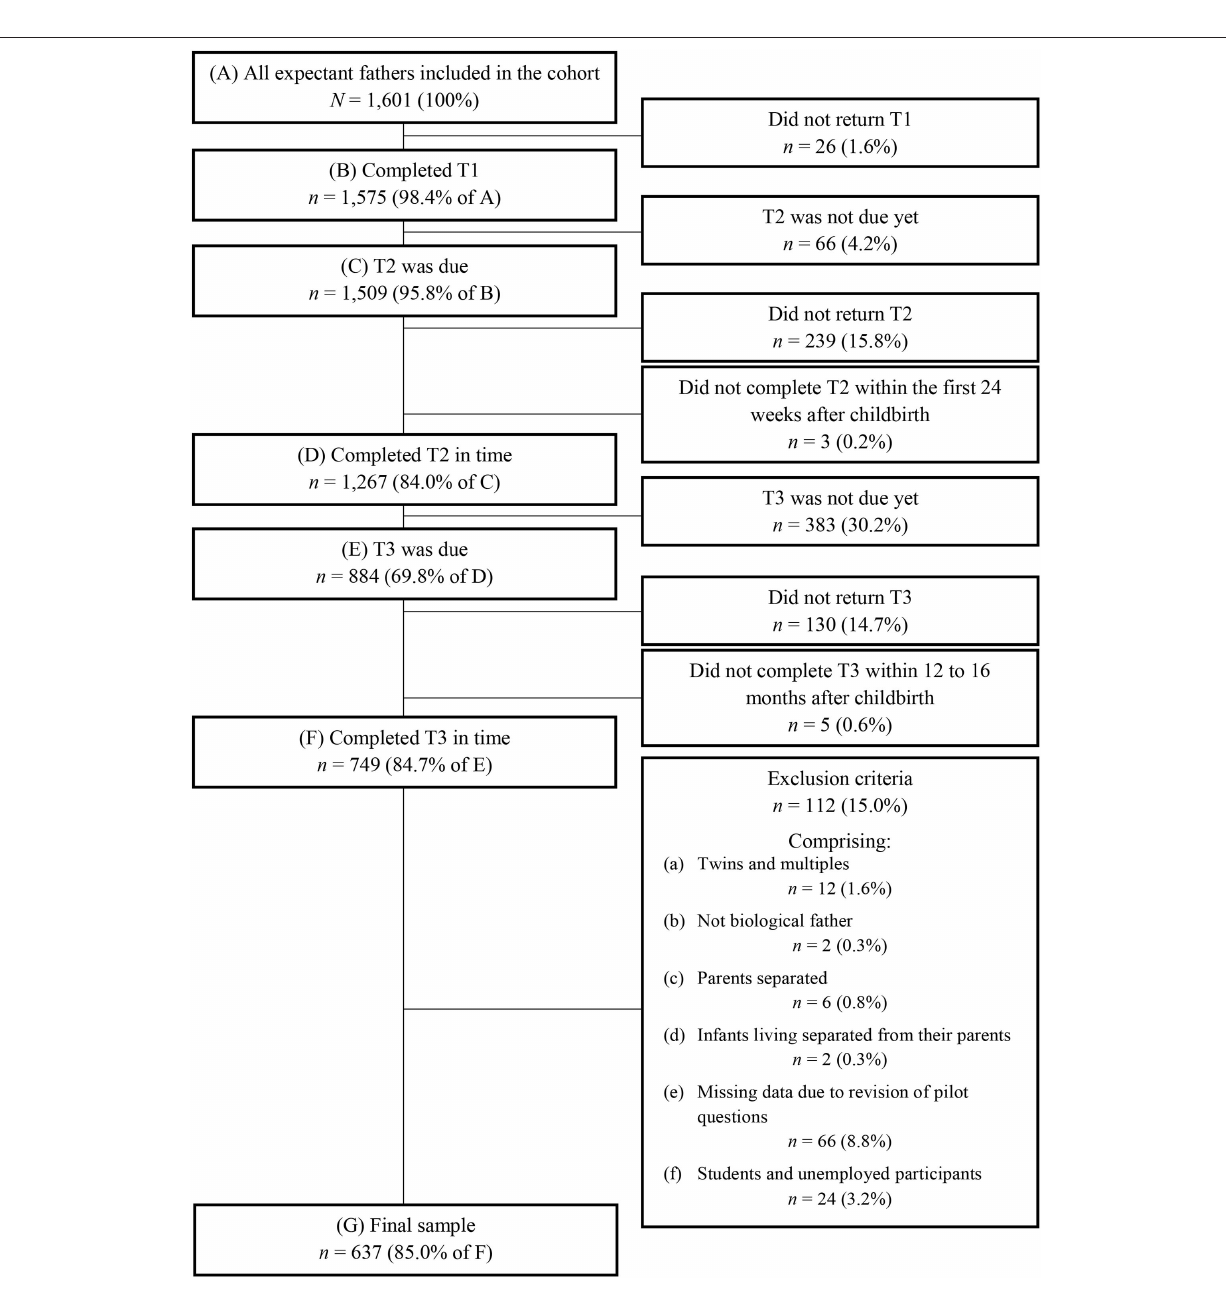
FIGURE 2 | Flowchart of retention rate and exclusion criteria resulting in final sample. T1, during pregnancy; T2, around 8 weeks after anticipated birth date; T3, around 14 months after actual birth date. Data from 3 rd of December 2020 (prospective data collection